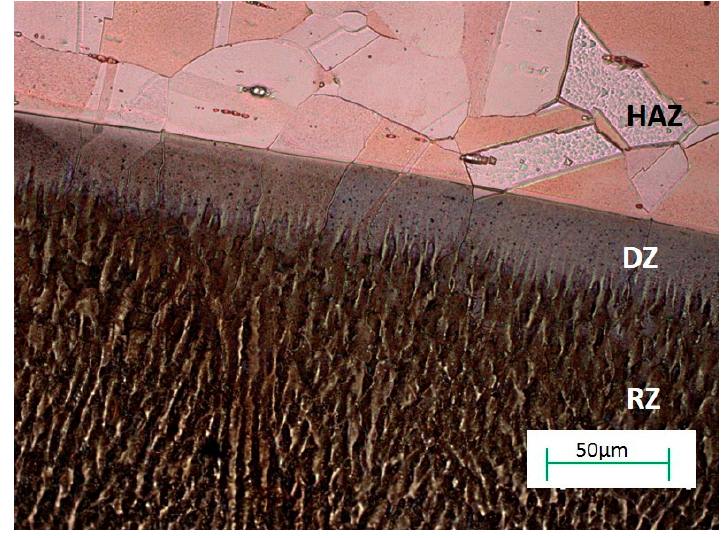
Figure 7. Optical microscopy image showing the microstructure of copper after Ti alloying.